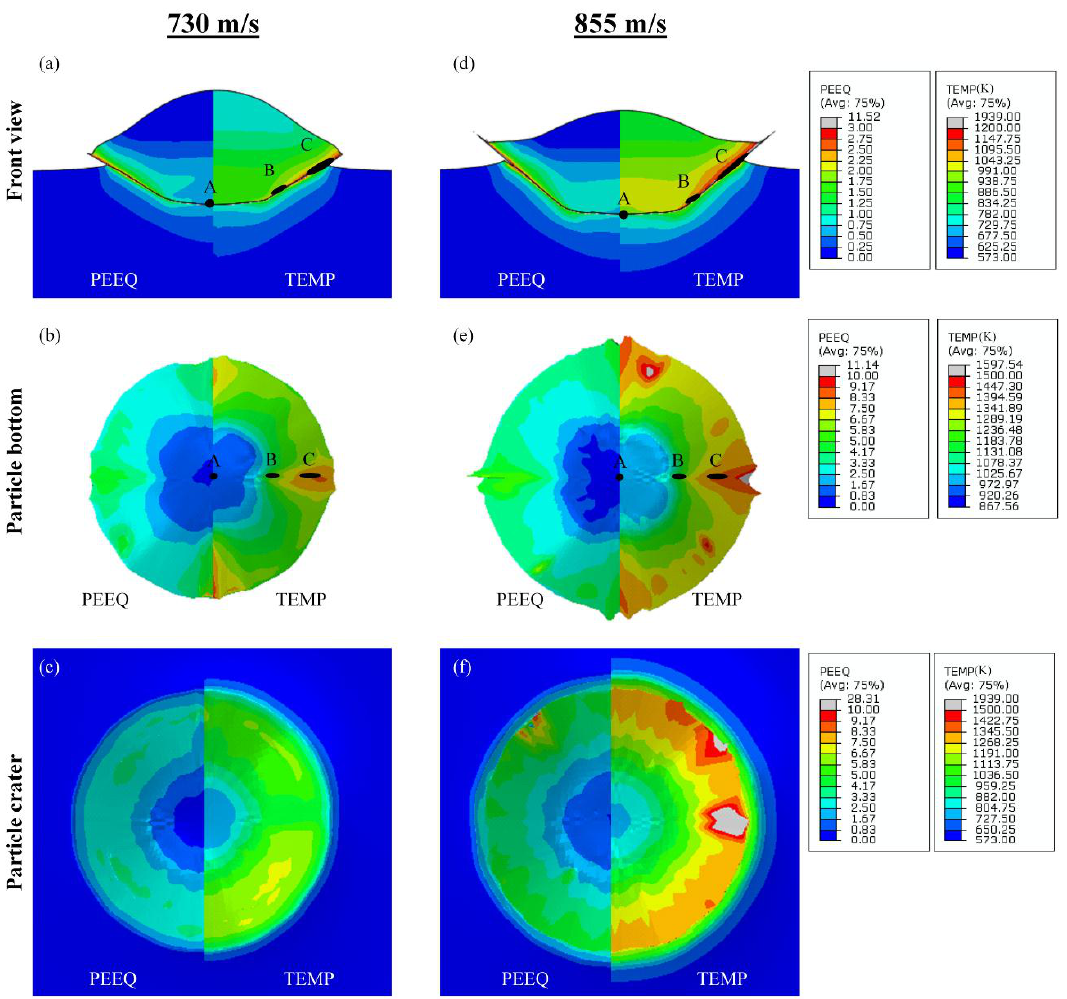
Figure 12. Figure 12. Simulated deformation and temperature profiles of a sprayed Ti64 particle impacted on a Ti64 substrate at velocities of ( a – c ) 730 m/s and ( d – f ) 855 m/s at 30 ns with ( a , d ) front view, ( b , e ) bottom view, and ( c , f ) crater